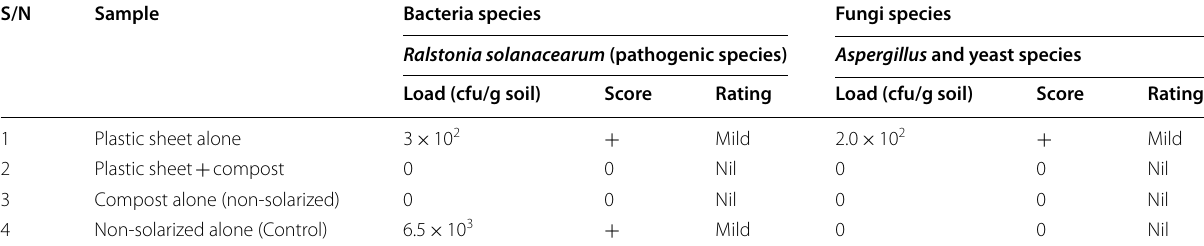
0: Nil, : Mild, : Moderate, : Severe + ++ +++ Table 6 Agronomic parameters of tomato plants grown in solarized and unsolarized soils